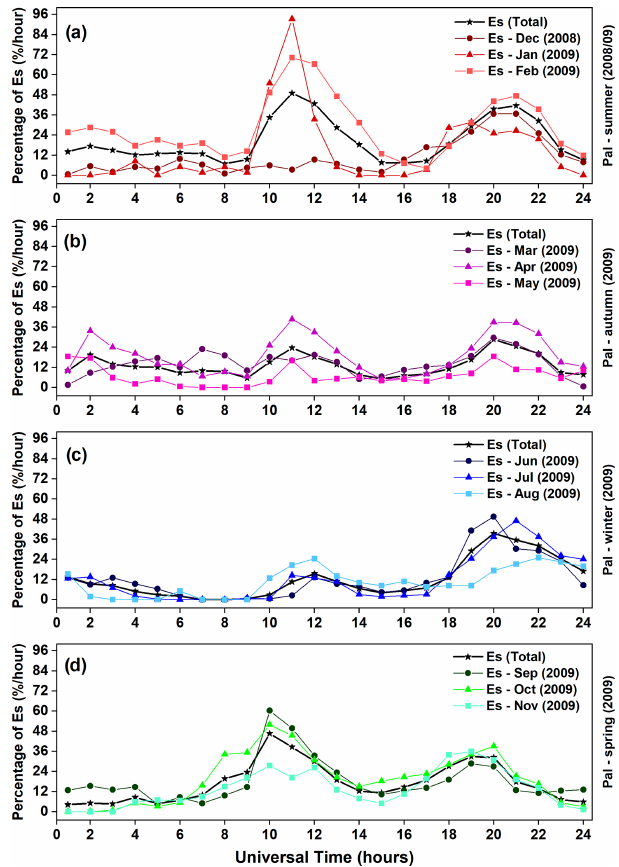
Figure 3. Temporal variation of the E s layer occurrence over Palmas separated into individual months during the summer (a) , autumn (b) , winter (c) , and spring (d)